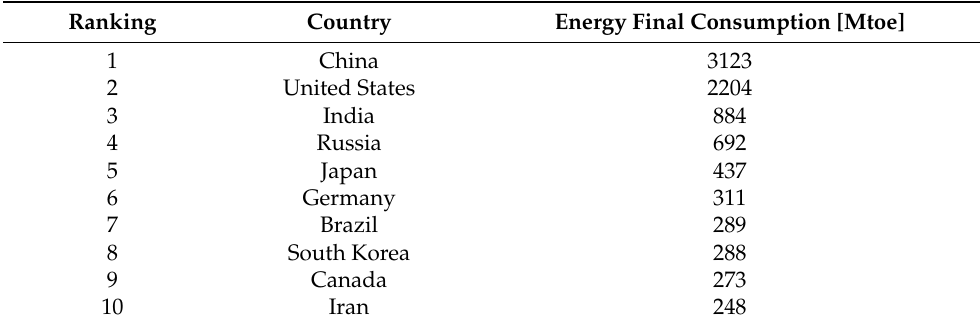
Table 4. Top-10 energy-consuming Countries (highest to lowest). Data of energy final consumption, excluding imports, exports, energy own-use, non-energy use and losses, are expressed in Million tons of oil equivalent (Mtoe). Data are referred to year 2016.